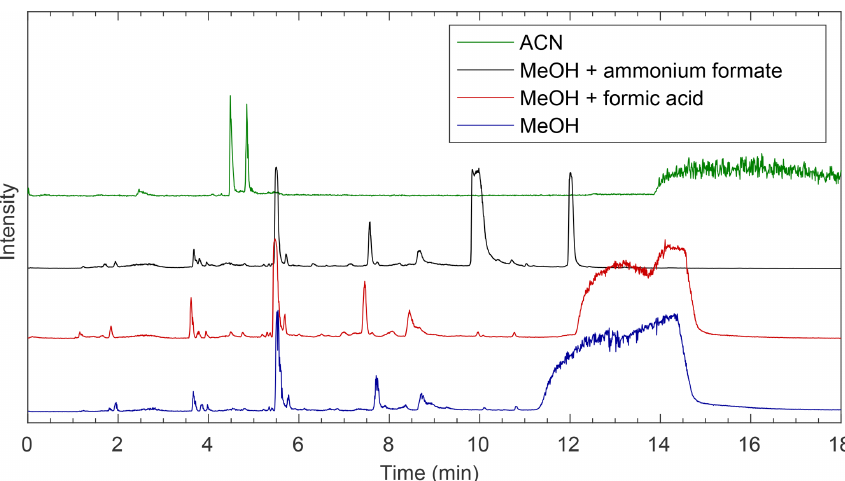
Figure 3. Comparison of EICs showing chromatography from methanol-based modifiers on the BEH column. The masses monitored are shown in Table S3. Mobile-phase modifiers can affect separation on the column as well as chemistry occurring in the ionization